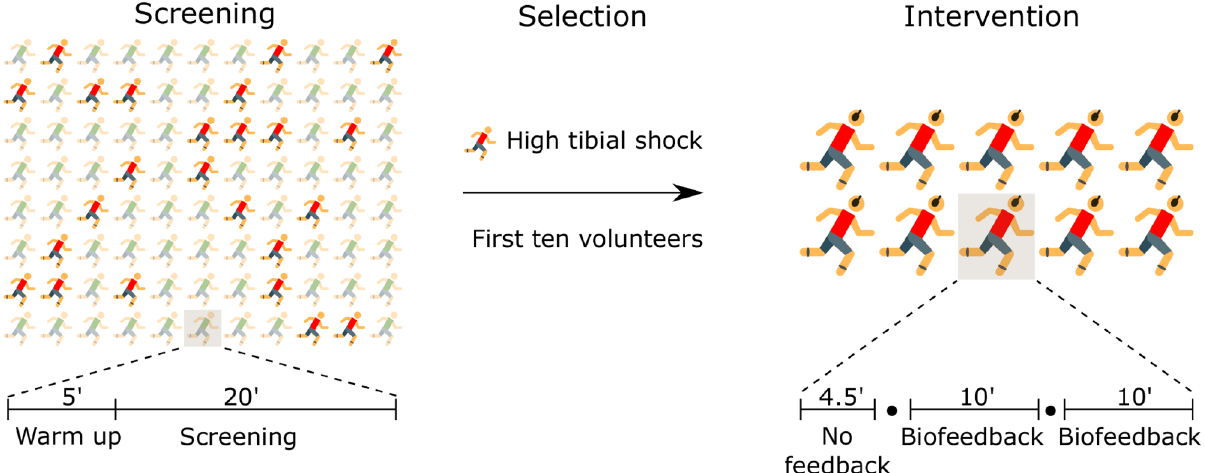
Figure 1. Schematic overview of the experimental design involving two running sessions (screening and intervention). A red icon represents a distance runner with high tibial shock. A filled circle indicates a system check and self-selected rest. Tibial shocks were detected in both sessions. The music-based feedback module was activated in the biofeedback